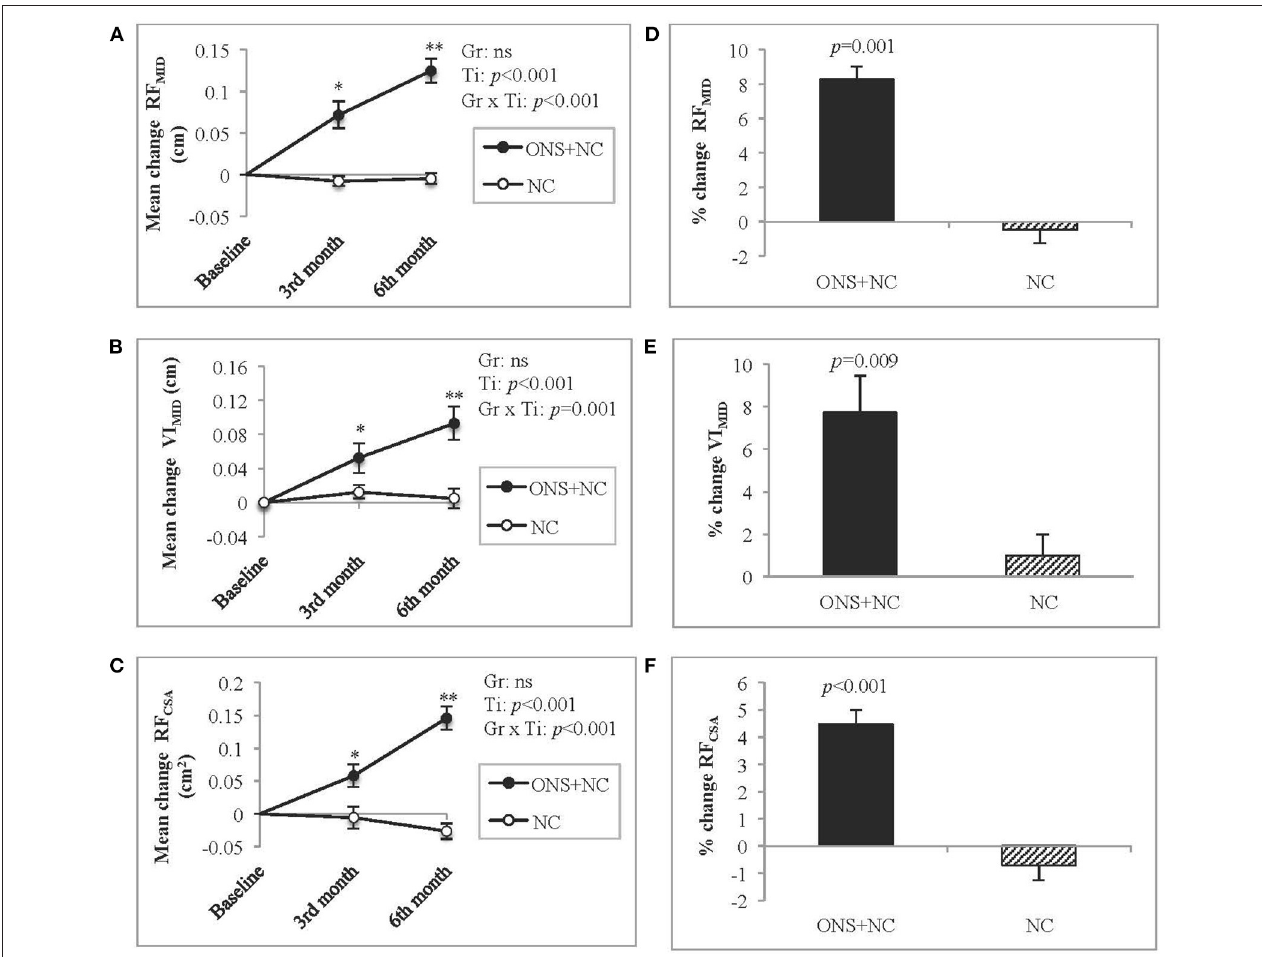
FIGURE 2 | Changes in US-derived muscle metrics. (A–C) represent mean changes according to US metrics for (A) RF MID , (B) VI MID , and (C) RF CSA , whereas (D–F) represent the percentage change for (D) RF MID , (E) VI MID , and (F) RF CSA . Gr, main effect of Group; Ti, main effect of Time, Gr × Ti, Group × Time interaction; * p